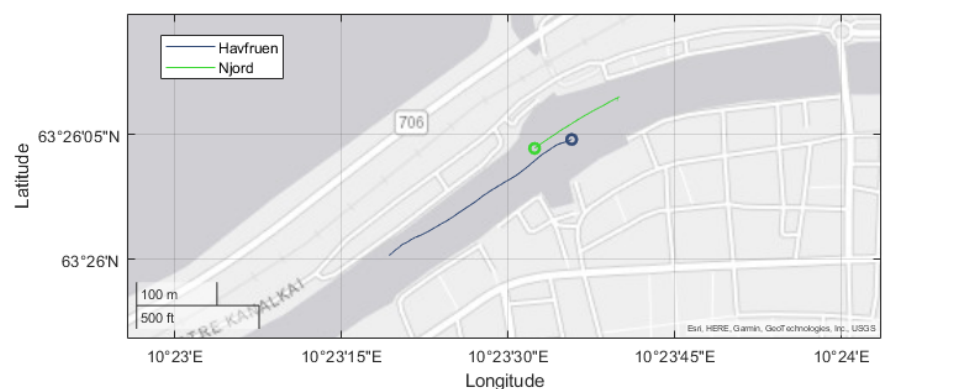
Figure 12. Test case 1—head-on passing encounter. The circle depicts the end